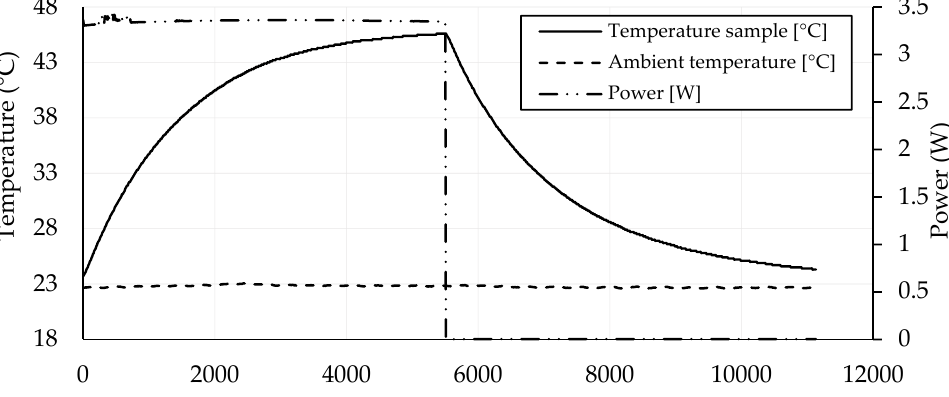
Figure 10. Self-heating experiment—CB 1.75, 100 V.